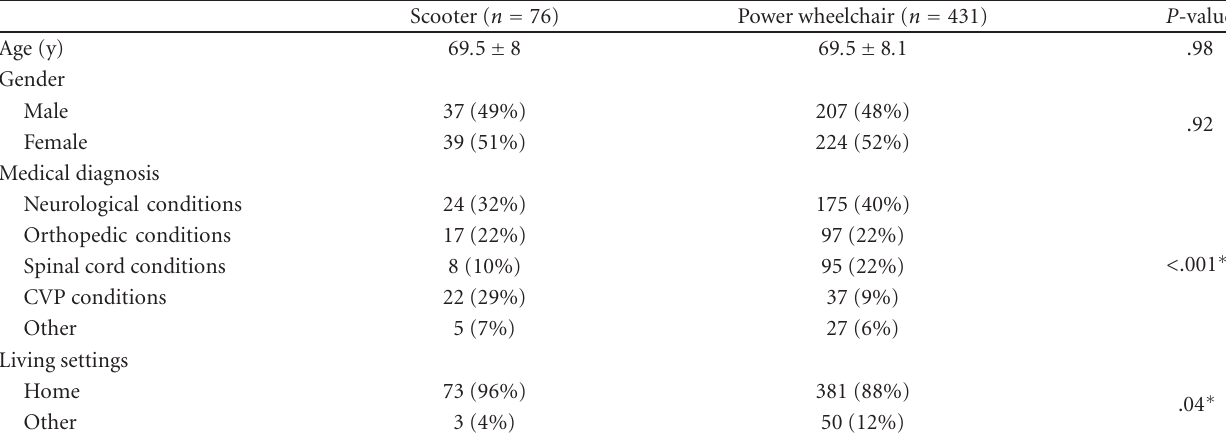
Table 5: Tier 4: Factors associated with use of scooters versus power wheelchairs.